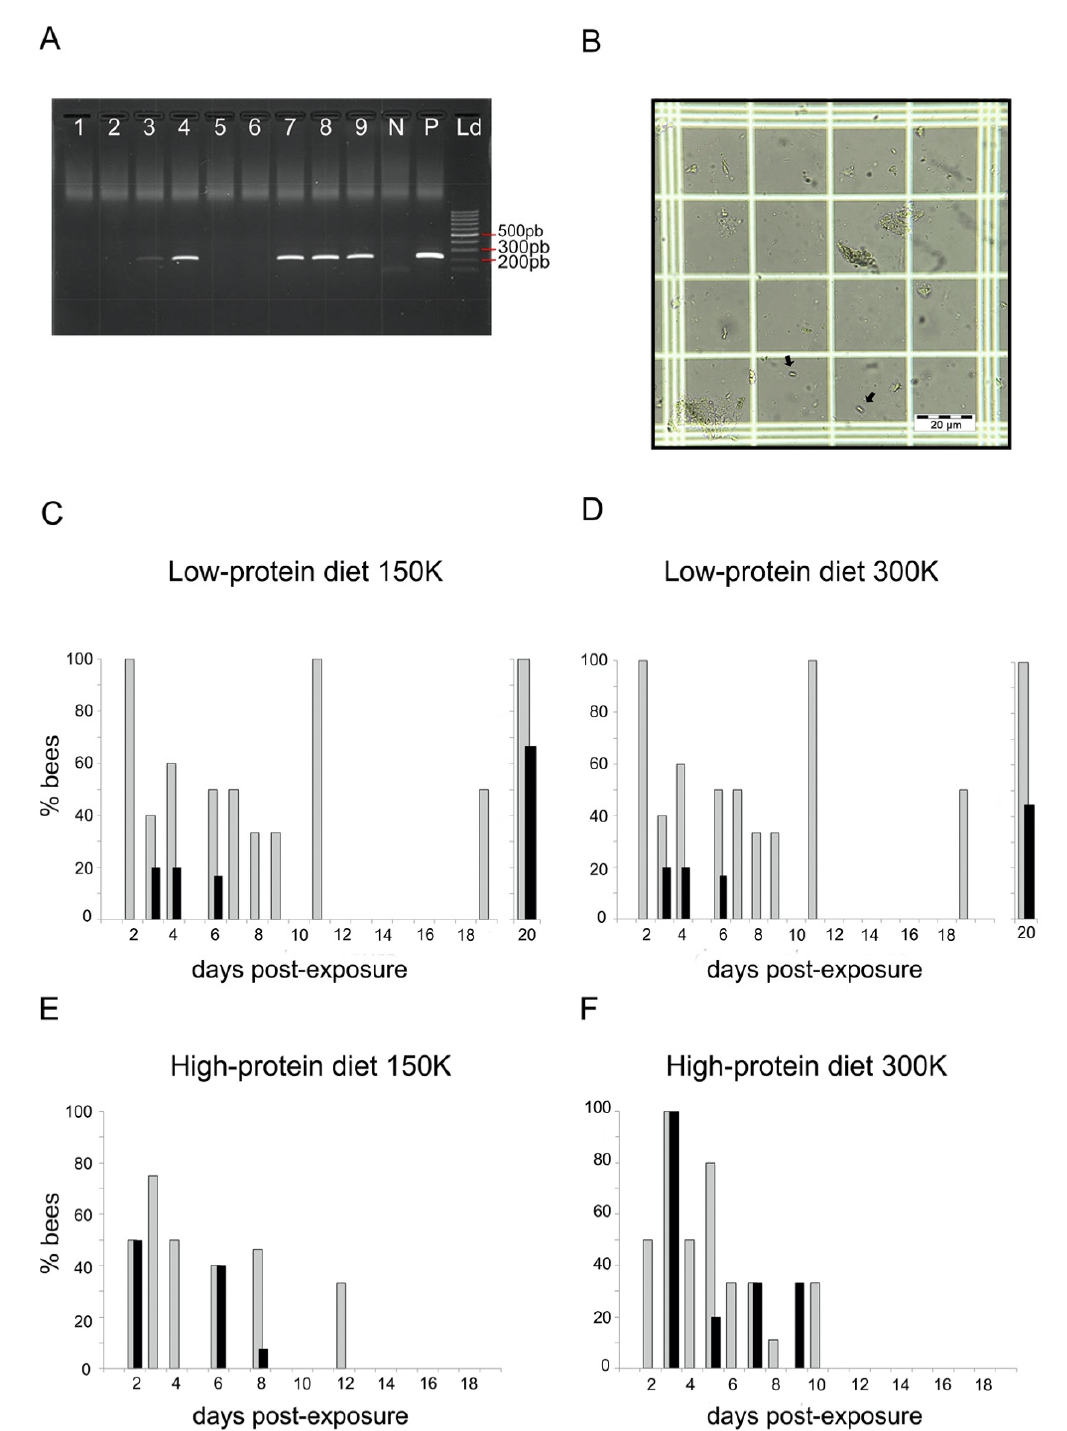
Figure 1. Parasite loads. ( A ) Example of agarose electrophoresis gel with negative (lanes 1, 2, 5, and 6) and positive (lanes 3, 4, 7–9) bumblebees to N. ceranae determined by PCR. N: negative control of PCR; P: positive control of PCR; Ld: molecular size marker (100 pb). ( B ) Example of N. ceranae spores observed in an infected bumblebee (optical microscope, × 400). ( C – F ) Proportion of dead bumblebees at different days postexposure that were PCR-positive to N. ceranae (grey bars) and showed spores in their gut (black bars) for both diets (high- and low-protein diets) and spore dosages (150 K and 300 K). Each group contained between 44 and 47 individuals.